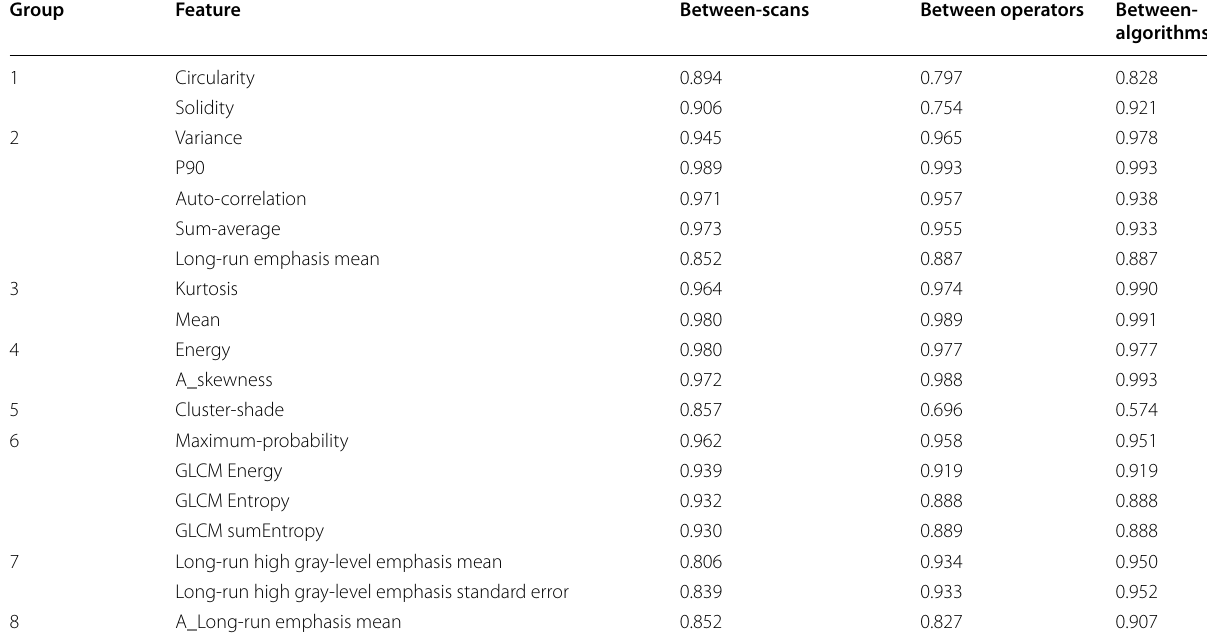
Table 6 Intraclass coefficient of quantitative image features